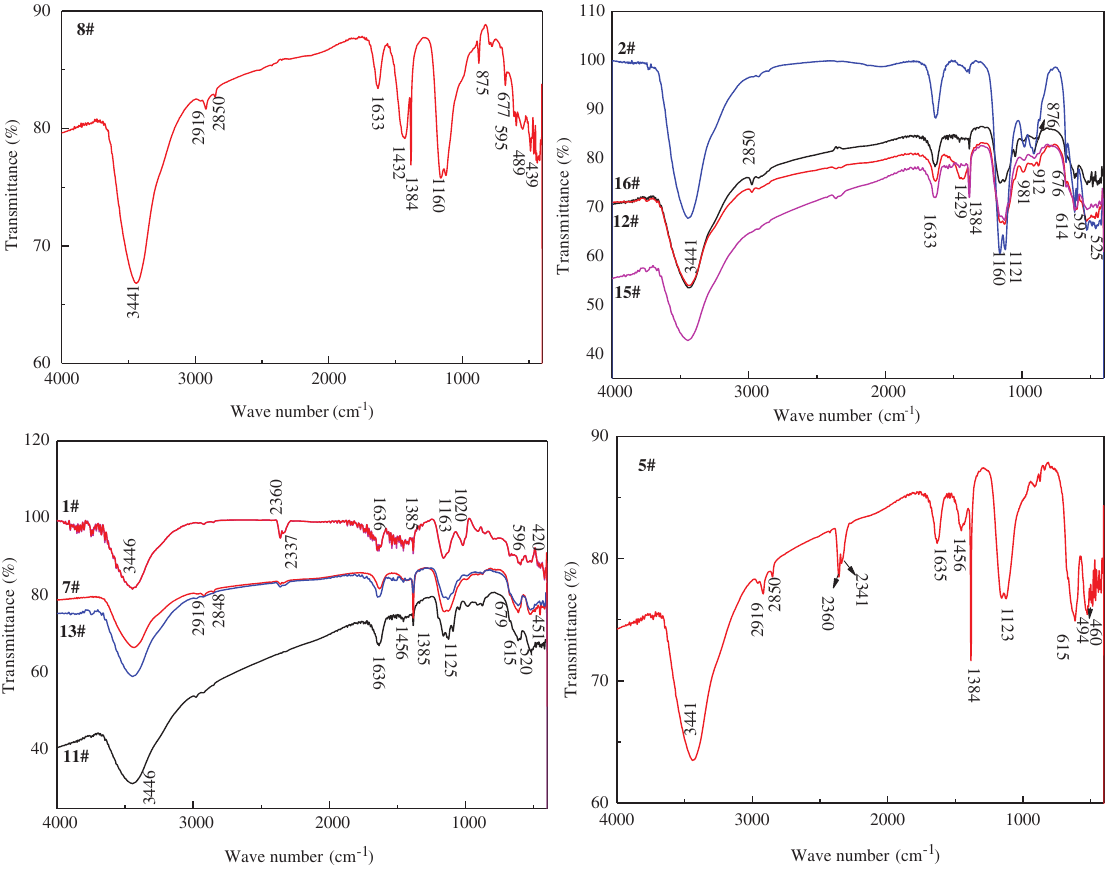
Figure 4: FT-IR spectra of zinc